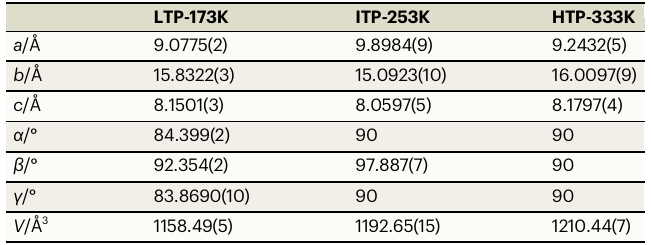
Table 1 | Normalized unit cell parameters of 1 in three phases based on the ITP